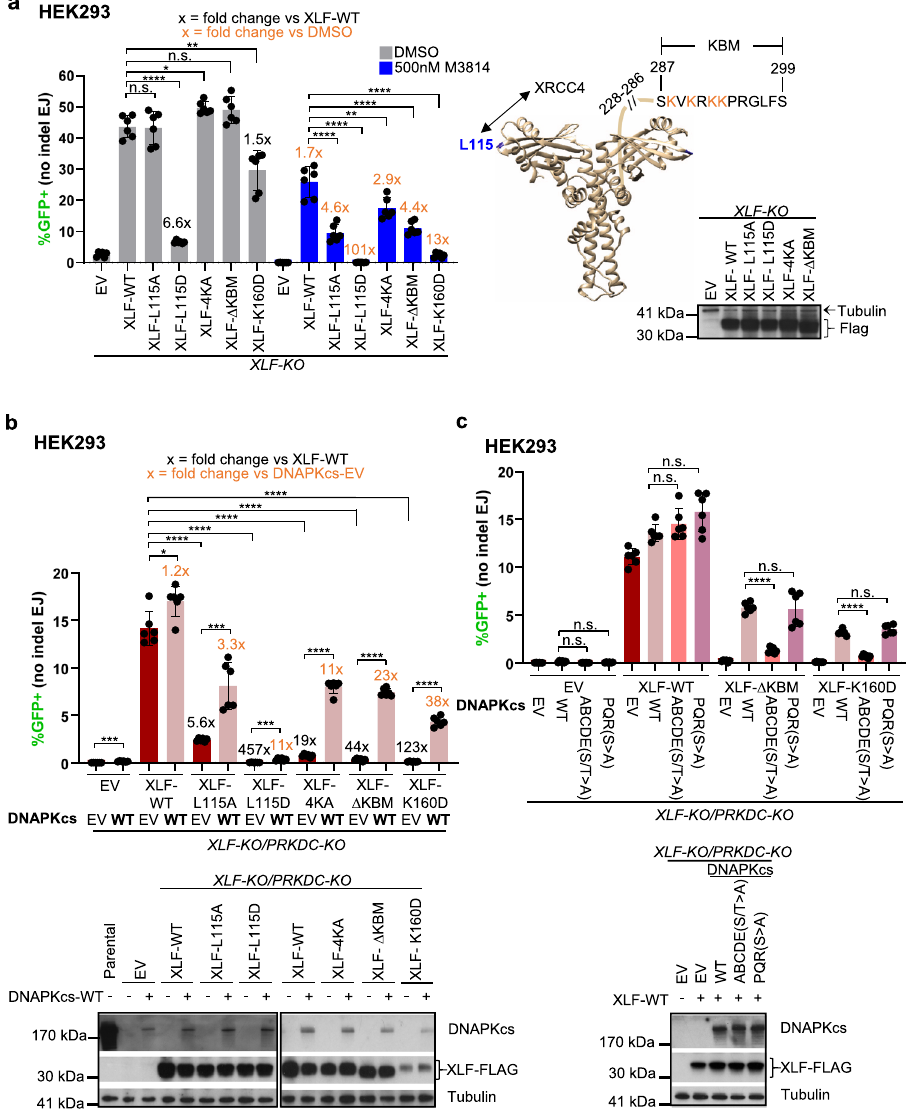
Fig. 5 DNAPKcs becomes essential for No Indel EJ in combination with other mutants in XLF binding interfaces, and depends on the DNAPKcs-ABCDE phosphorylation sites cluster. a DNAPKcs kinase inhibition has a markedly greater effect on No Indel EJ in cells with XLF mutants disrupting the XRCC4 or KU interaction interfaces. n = 6 biologically independent transfections. Statistics with unpaired two-tailed t test using Holm-Sidak correction. **** P < 0.0001, XLF-WT DMSO vs. XLF-K160D DMSO ** P = 0.00327, XLF-WT 500 nM M3814 vs. XLF-4KA 500 nM M3814 ** P = 0.00565, * P = 0.0131, n.s. not signi fi cant. Also shown is the XLF homodimer (aa 1 – 227, Protein Data Bank 2R9A, with the C-terminus for one monomer drawn as a line), with the L115 residue important for XRCC4 interaction, Ku Binding Motif (KBM), and 4 lysine (K) residues in the KBM highlighted. Immunoblot shows levels of FLAG-tagged XLF-WT and mutants. b DNAPKcs is required to promote No Indel EJ in cells with XLF mutants disrupting the XRCC4 and KU interaction interfaces. n = 6 biologically independent transfections. Statistics as in ( a ). **** P < 0.0001, XLF-EV DNAPKcs-EV vs DNAPKcs-WT *** P = 0.000169,